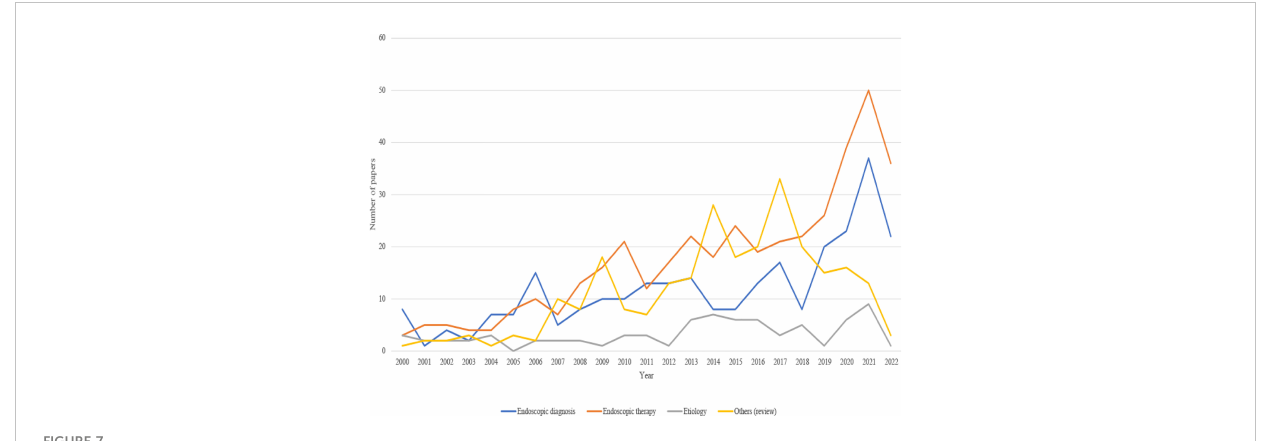
FIGURE 7 Annual research trend of publications of endoscopes on EGC over the past 20 years.